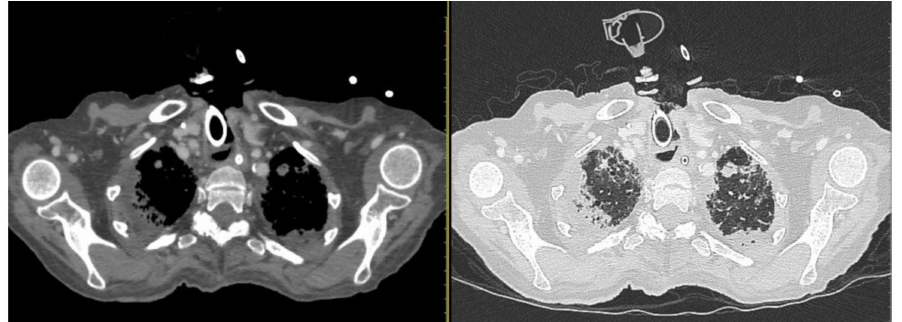
Figure 3. CT scan windows showing metastasis and inflammatory phenomena on both sides of the lung. (On the left, axial parenchymal lung section. On the right, axial lung window). During hospitalization, bacterial pneumonia began, worsened by secondary viral (Cytomegalovirus) and fungal pneumonia. The patient received a triple antibiotics course with an antiviral, an antifungal, and systemic and local inhalational corticosteroids. However, despite the medical therapy, the chest condition deteriorated progressively (Figure